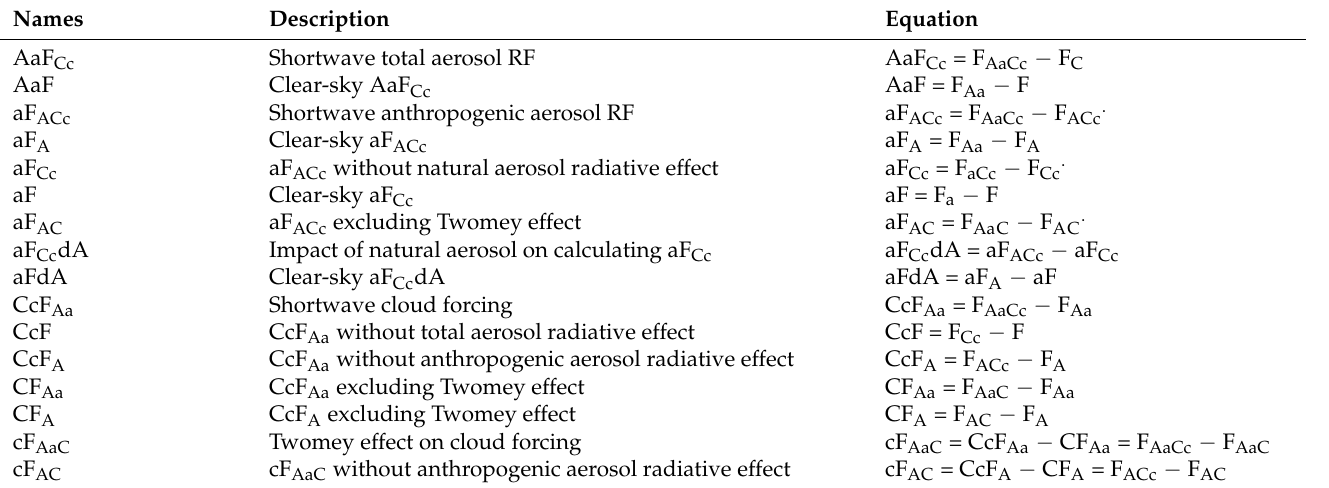
Table 2. List of model diagnostic instantaneous radiative forcing (RF) variables.